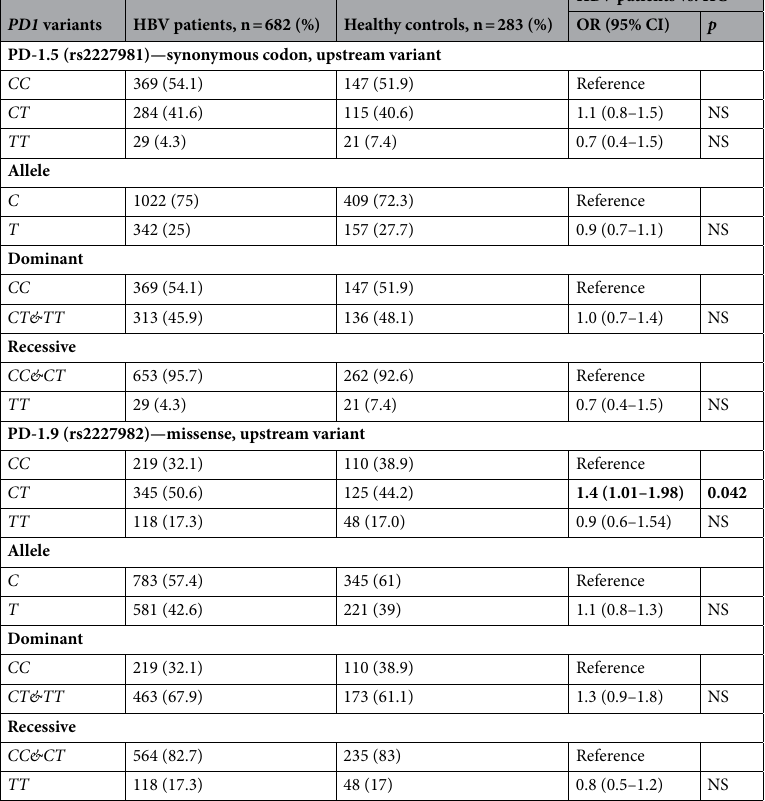
Table 2. Association of PD1 polymorphisms with susceptibility to HBV infection. OR odds ratio, n number of chromosomes. ORs and P- values were calculated by using binary logistic regression model adjusted for age and